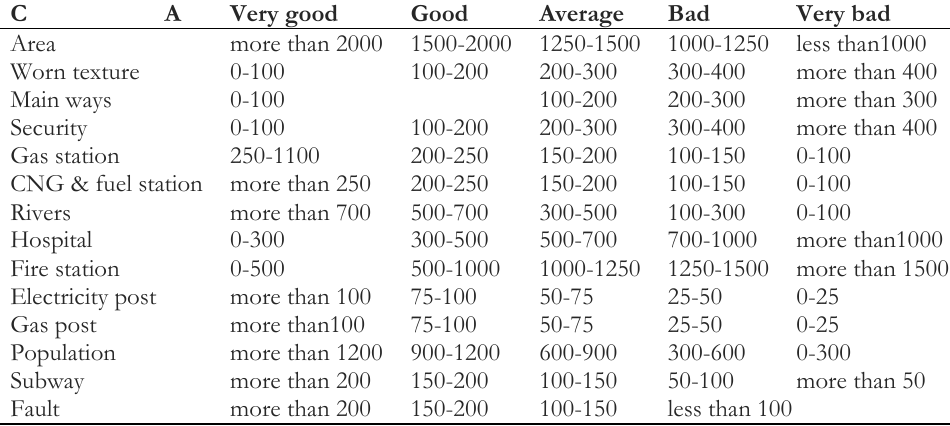
Table 2. Classification and evaluation of